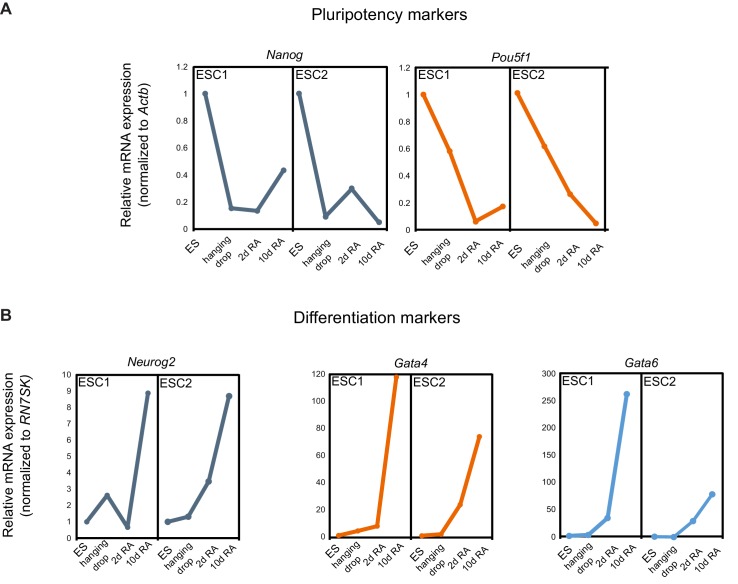
Retinoic acid differentiation of ESCs.(a) Quantification of pluripotency markers, Nanog and Pou5f1 (Oct-4) expression by qRT-PCR upon differentiation with retinoic acid (RA), and normalized to Actb expression, during pluripotency (ESC), after 2 days in hanging droplets, 2 days (2d RA) and 10 days in retinoic acid (10d RA) (b) Quantification of differentiation markers expression, Neurog2, Gata6 and Gata4 upon differentation with retinoic acid, as in (a). Both panels include data of one representative experiment.